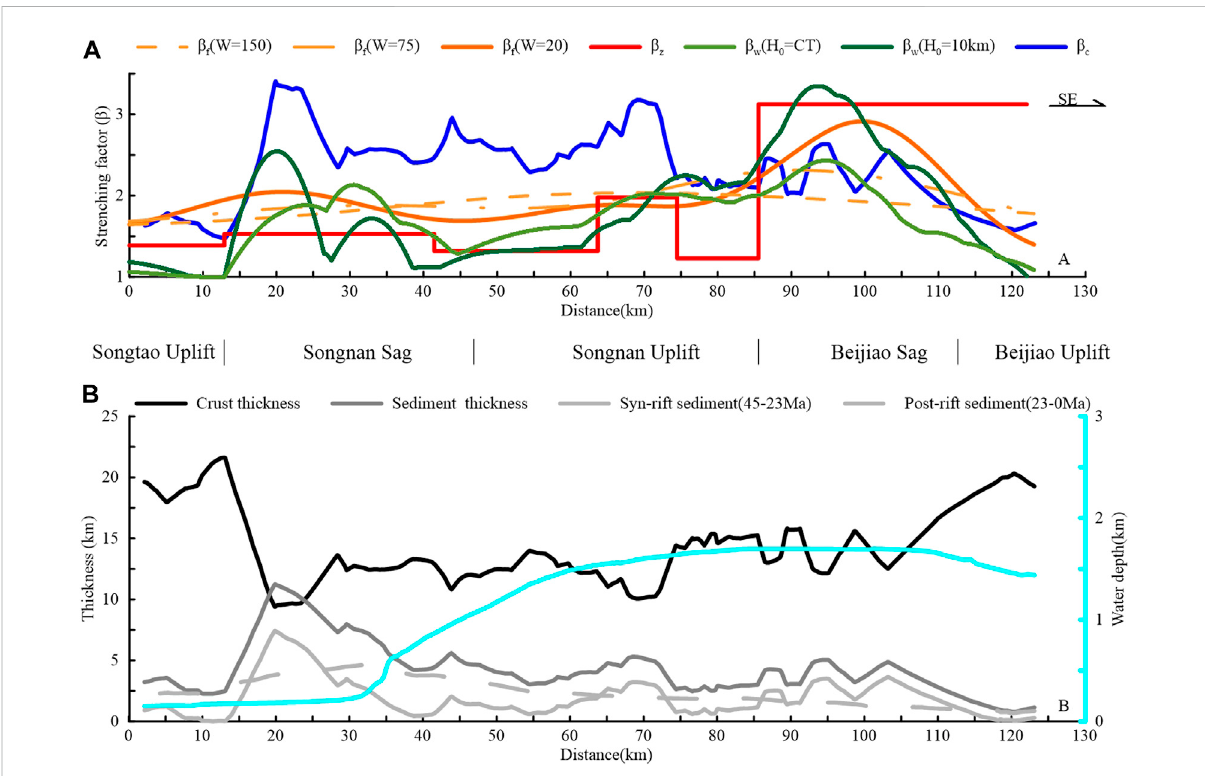
FIGURE 7 (A) β -Pro fi lesalong Line 1,evaluated bydifferent methods andparameters. (B) Crust thickness, sediments thickness and water depth alongLine 1.Sedimentthicknessesofthetotal,syn-riftandpost-riftareshown.Thecrustthinnedsharplyfrom21.6to9.4 kmovera~7 kmdistanceatthenorth of Songnan Sag, which corresponds to the transition of thickest to thinnest